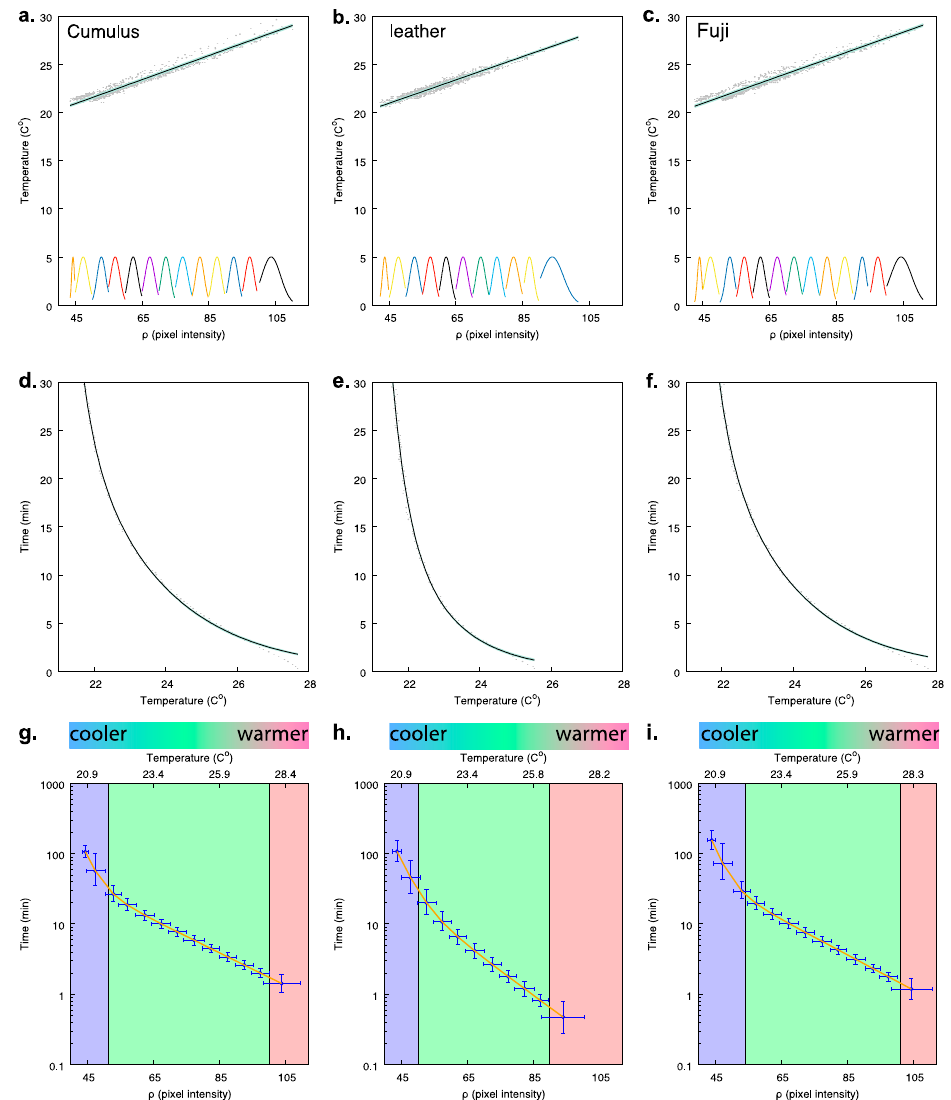
Figure 3. Experimental data and modelling results for a method allowing the prediction of cooling time of three different shoes—Cumulus (first column), leather (middle column), and Fuji shoe (third column)—from pixel values of a thermal imaging device in typical room conditions after wearing three different types of shoes (refer to Materials and Methods section for details). Panels ( a – c ) show the relationship between camera response, expressed as pixel intensity values ( ρ ), and shoe temperature reading of the FLIR i50 30 min after shoe removal. Points represent experimental data, the solid black line represents the predicted function, and the shaded area represents the 95% confidence intervals for the function. The curves at the bottom of each panel represent the shape of the probability density distribution (pdf) of the camera responses at 11 different intensity levels modelled assuming a beta distribution (See Supplementary Materials for coefficients defining each distribution); Panels ( d – f ) show temperature as a function of time for the tested shoe types modelled assuming a bi-exponential function. Points represent the experimental data from the Temperature Sensor Meter, the solid black line represents the nonlinear regression function, and the shaded area represents the 95% confidence intervals. Panels ( g – i ) represent the cooling function for each shoe type: ( g ) Cumulus, ( h ) leather, and ( i ) Fuji shoe. Error bars on the x-axis represent 95% confidence intervals for camera responses at different pixel intensity values, whilst error bars on the y-axis represent the 95% confidence intervals of the predicted cooling time. In panels ( g – h ), the green shaded area represents the temperature range for which time can be reliably predicted from camera responses. Blue and red areas represent areas of high uncertainty where data should be interpreted with